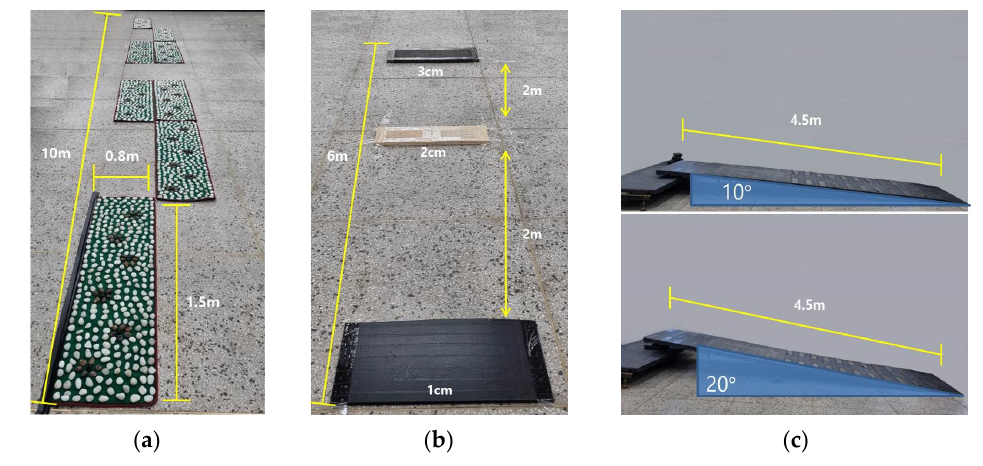
Figure 5. ( a ) Uneven terrain; ( b ) obstacle terrain; ( c ) sloped terrain.